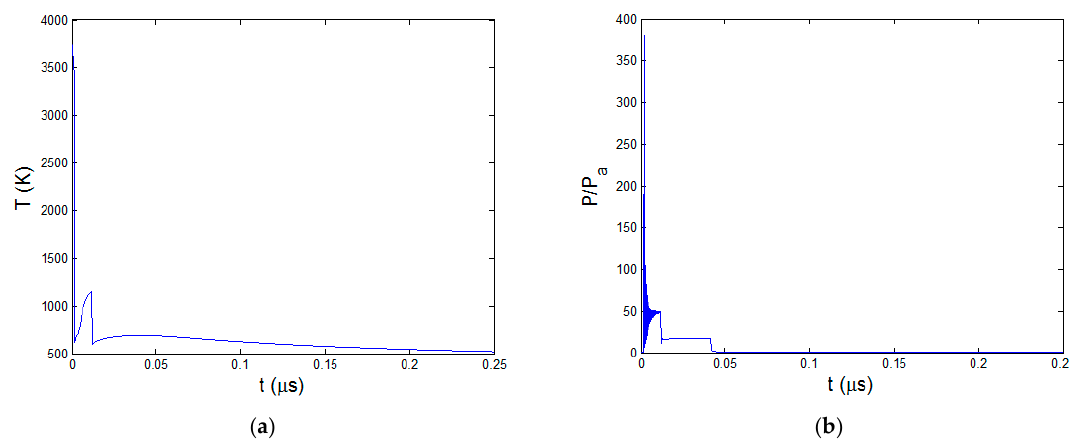
Figure 7. At the pyrolysis boundary x b ( a ) Temperature curve; ( b ) Pressure curve.